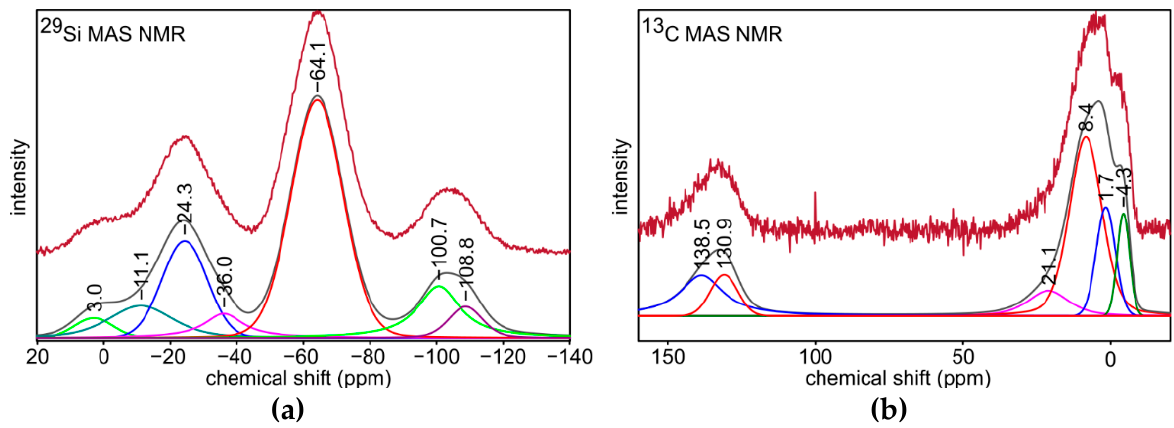
Figure 4. ( a ) 29 Si and ( b ) 13 C MAS NMR spectra for S4 sample. Table 3. Calculated percentage share of the structural units in the structure of S4 sample based on 29 Si MAS NMR experiment.